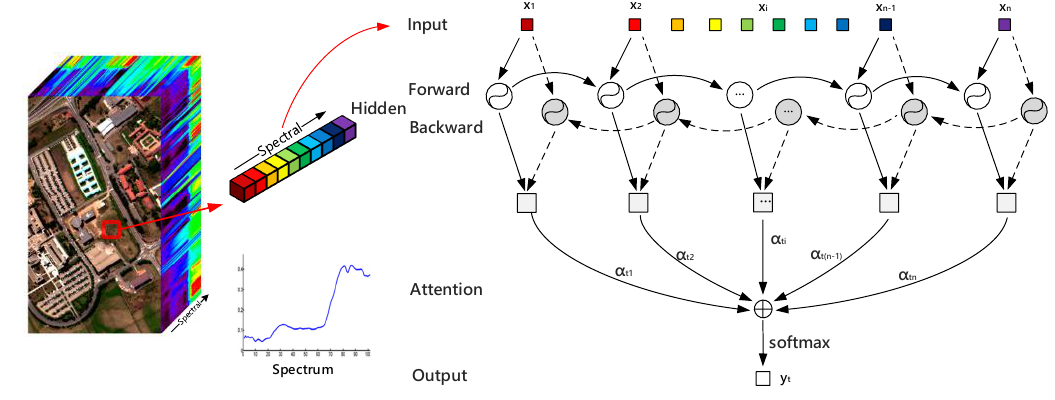
Figure 4. Bi-RNN model with attention mechanism for spectral classification. Every pixel vector is regarded as a sequence, the hundreds of spectral bands are input into the gated recurrent unit (GRU) cell one by one. Both forward and backward features are captured by Bi-RNN and re-weighted by the attention